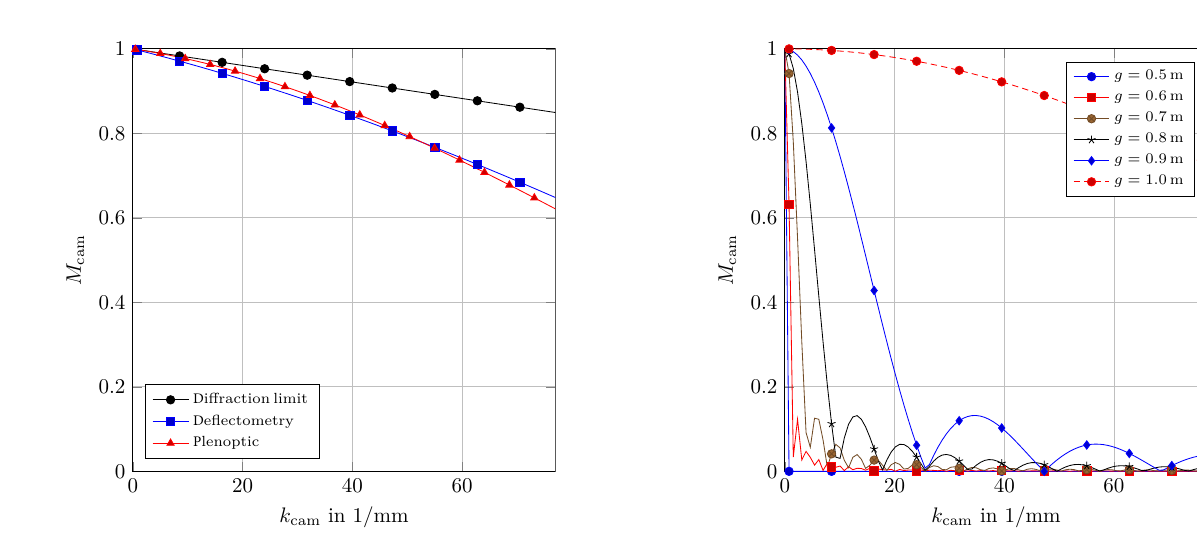
with k = k cam and